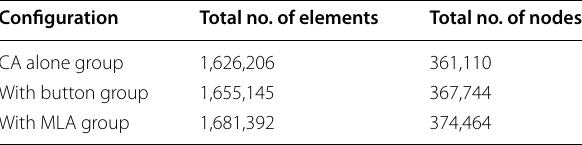
Table 3 Parameters of normalized-based relaxation function